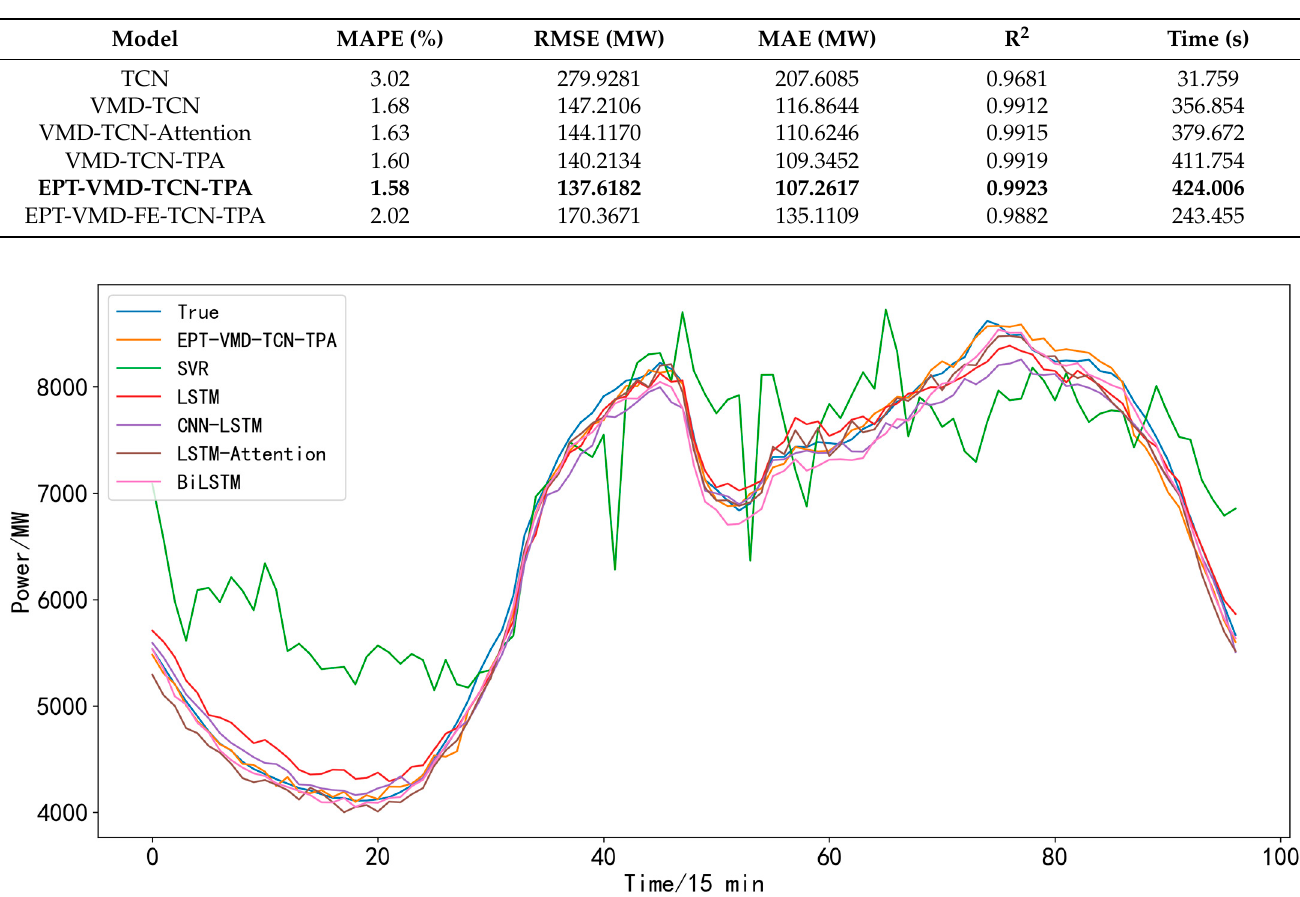
Figure 21. Area 2 ablation experiment prediction results. Table 12. Area 2 ablation model evaluation indicators.